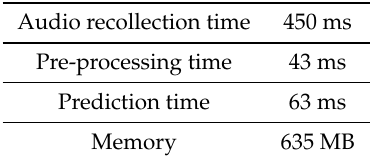
Table 9. Mean computational costs of the proposed device